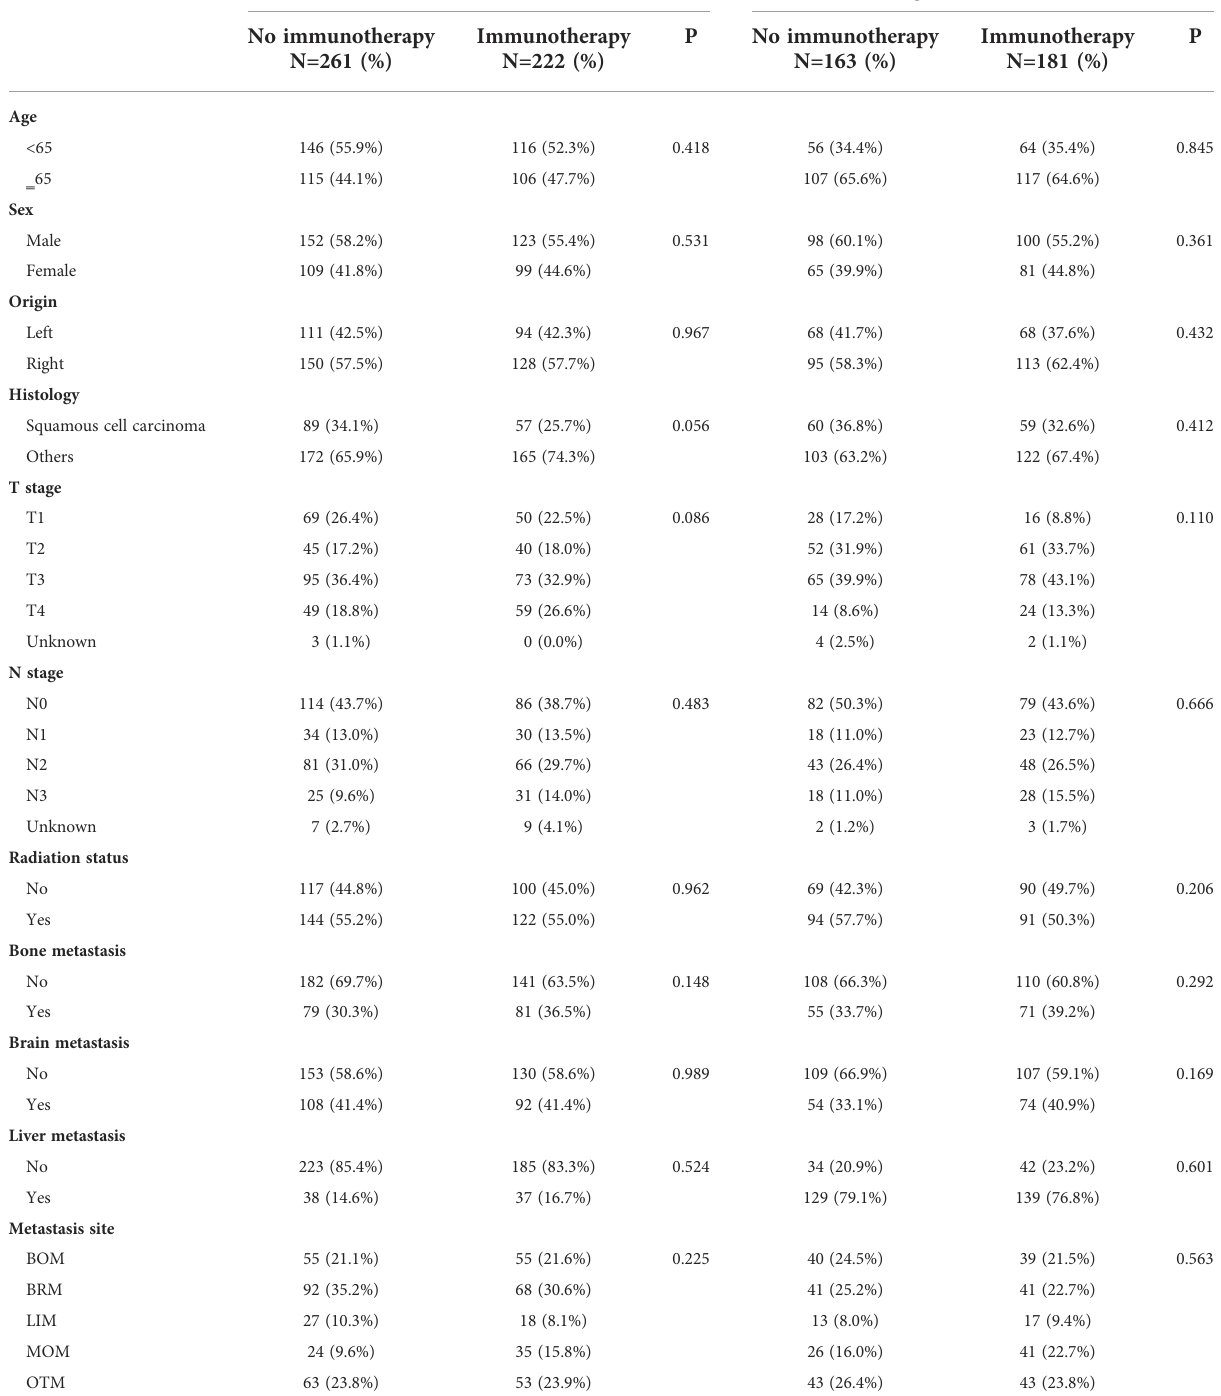
TABLE 2 Characteristics of all patients according to receipt of immunotherapy in each